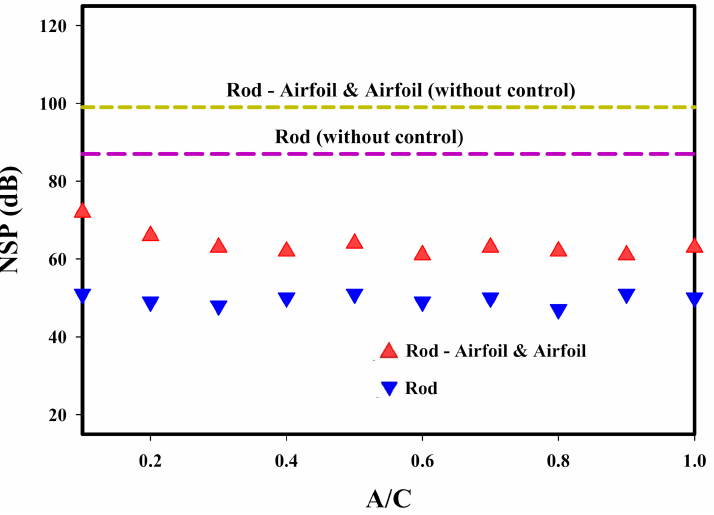
Figure 13. Noise variations recorded by altering the rod displacement (NSP-A/C) at α = 0 ◦